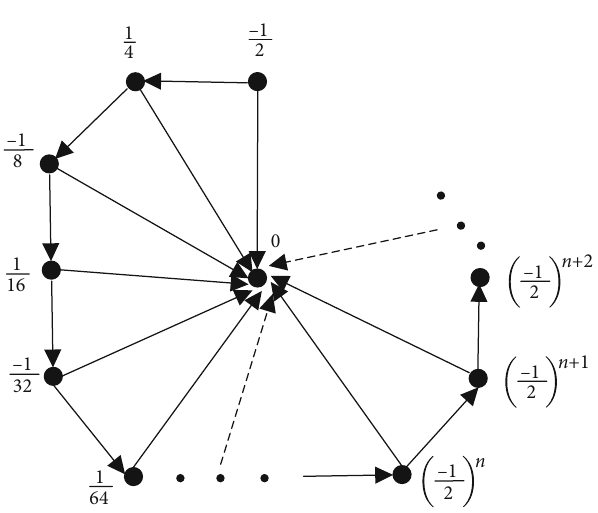
Figure 1: All loops and isolated vertices are not